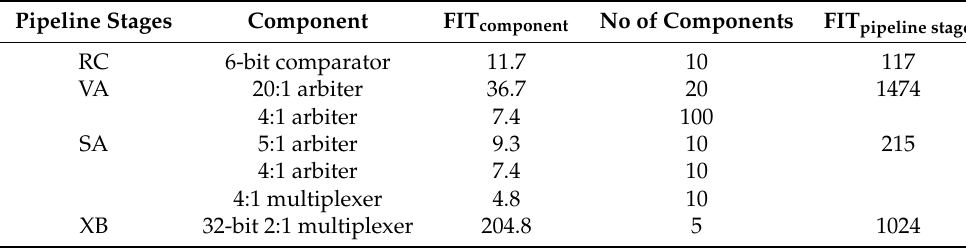
Table 1. FIT Values of Generic 2-Stage NoC